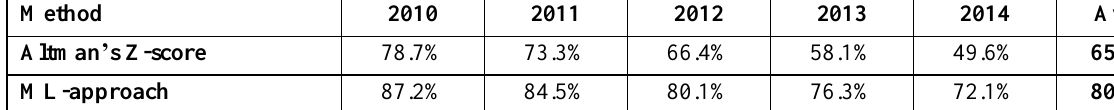
Table 7. Precision: Altman’s Z-score vs ML-approach